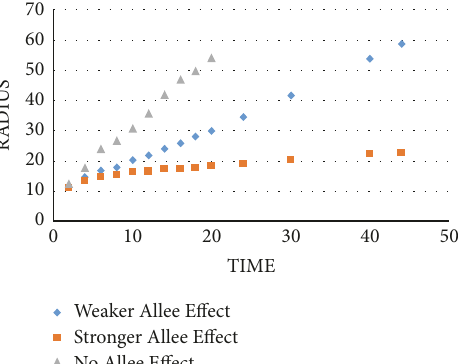
Figure 10: The impact of weak Allee effect on the spreading speed of avascular tumor. If the weak Allee effect is strong, the growth of a tumor appears to be exponentially at the beginning, approximately linearly, and then reaches a plateau.